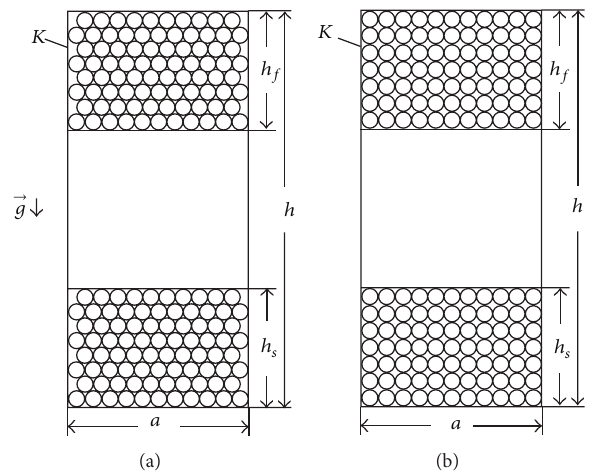
Figure 1: Vertical axial section of straight square prismatic container with separated components of the liquid dispersion: (a) model of perfect close packing of the particles from the dispersion phase; (b) model of nonperfect close packing of the particles from the dispersion